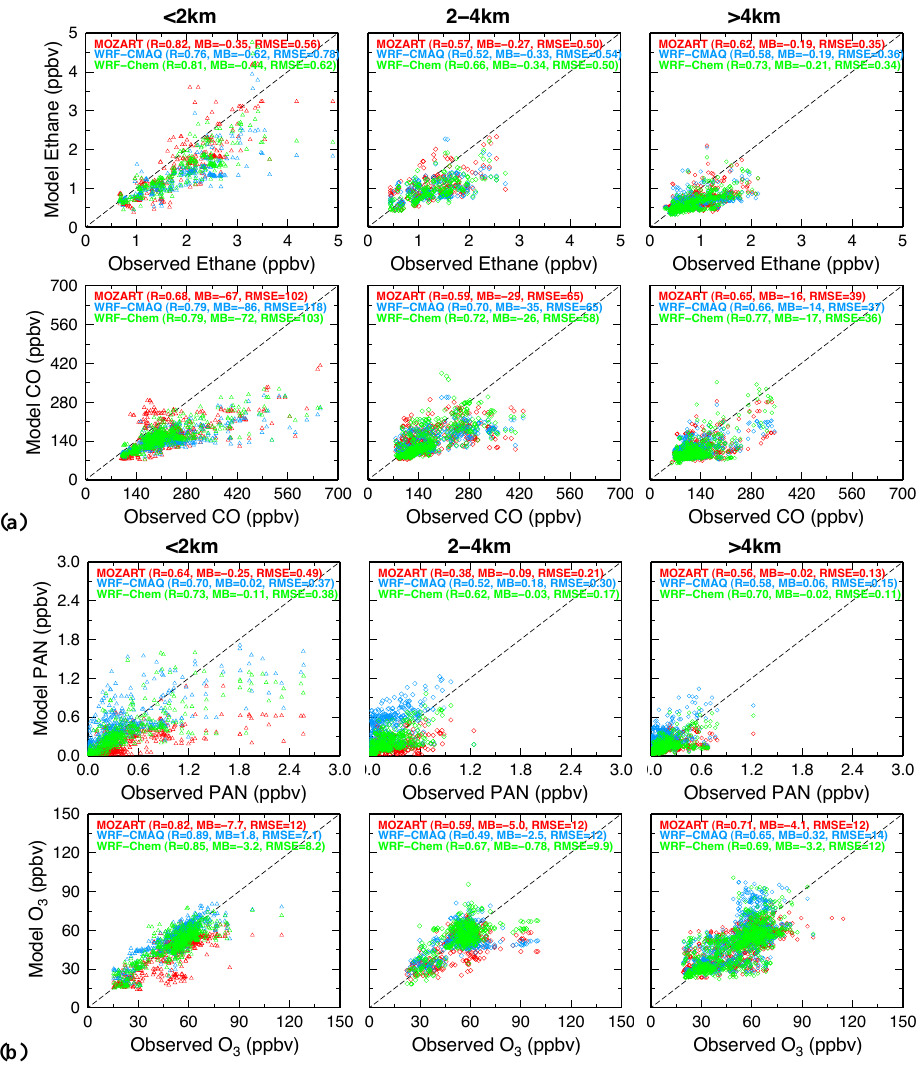
Figure 1b. Same as Figure 1a, but for photochemical oxidants O 3 and PAN Fig. 1. (a) Comparison of measured (5-min merged) and modeled CO and ethane along the TRACE-P flight tracks in March 2001. Scatter plots are shown for flight sections at altitudes below 2km (left panel), 2–4km (middle panel), and above 4km (right panel). Data points with stratospheric influences diagnosed by O 3 /CO > 1.25 are omitted. Correlation coefficient ( R ), mean bias (MB, inppbv) and root mean square error (RMSE, in ppbv) are calculated for each model: MOZART (red), WRF-CMAQ (blue), and WRF-Chem (green). (b) As (a), but for photochemical oxidants O 3 and